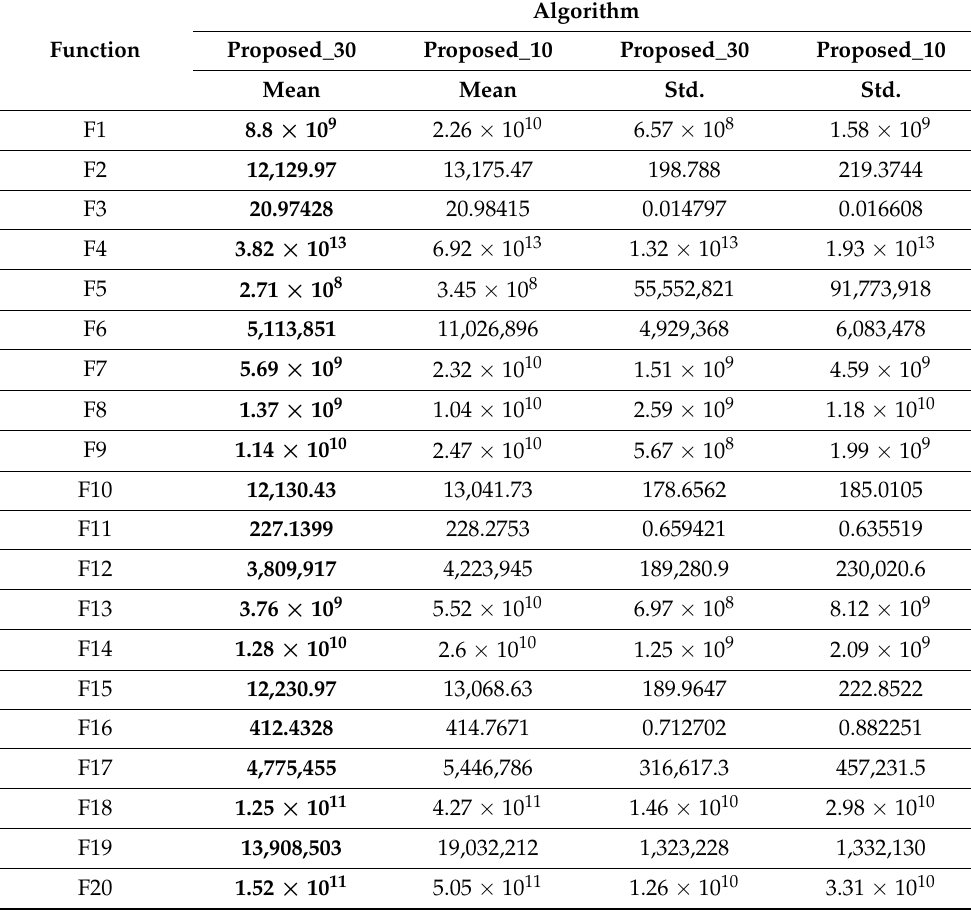
Table 2. Comparison of S 2 SMA (proposed) with 10 and 30 search agents.